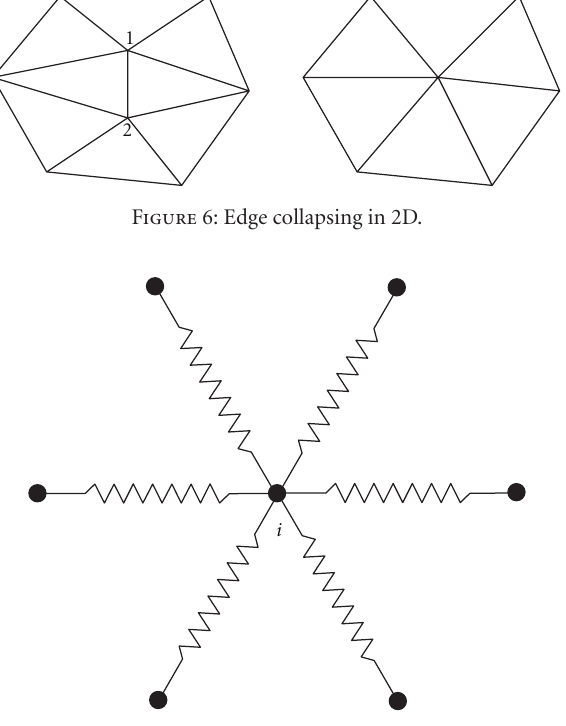
Figure 7: Spring analogy: springs replacing segments.